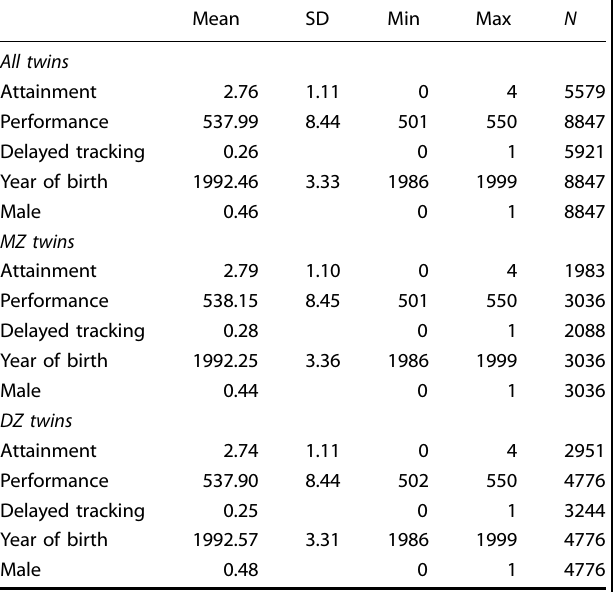
Table 5. Descriptive information on the variables used in the analyses for all twins together and for identical and fraternal twins